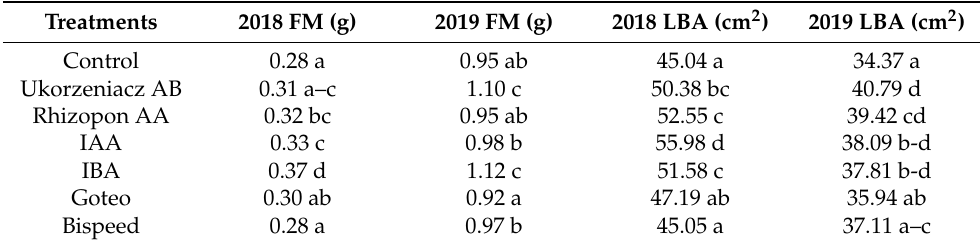
Table 5. Fresh mass (FM) and leaf blade area (LBA) of softwood cuttings of ‘GiSelA 5’ rootstock depending on the tested treatments in the years 2018–2019.